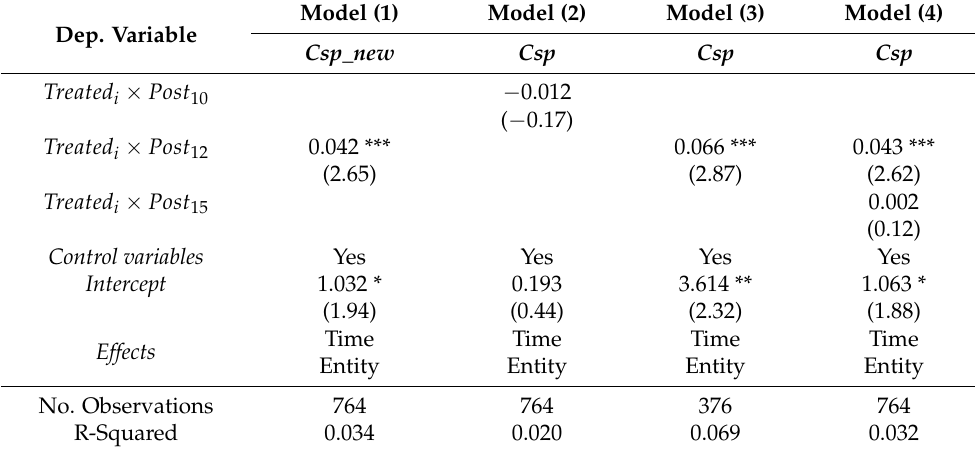
Table 5. Results of robustness